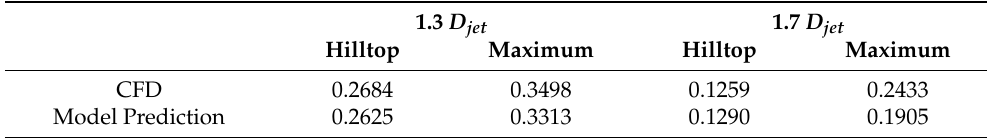
Table 3. Speedup ratio of different radial